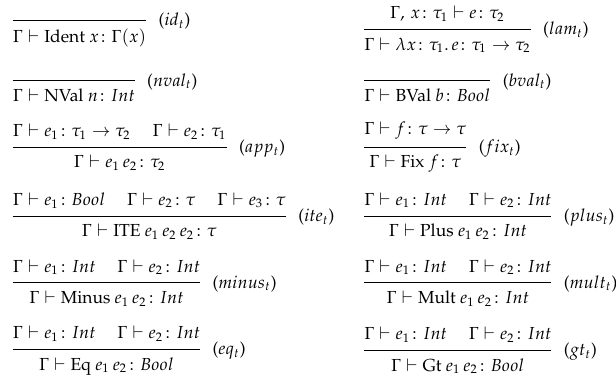
Figure 4. Typing judgments.